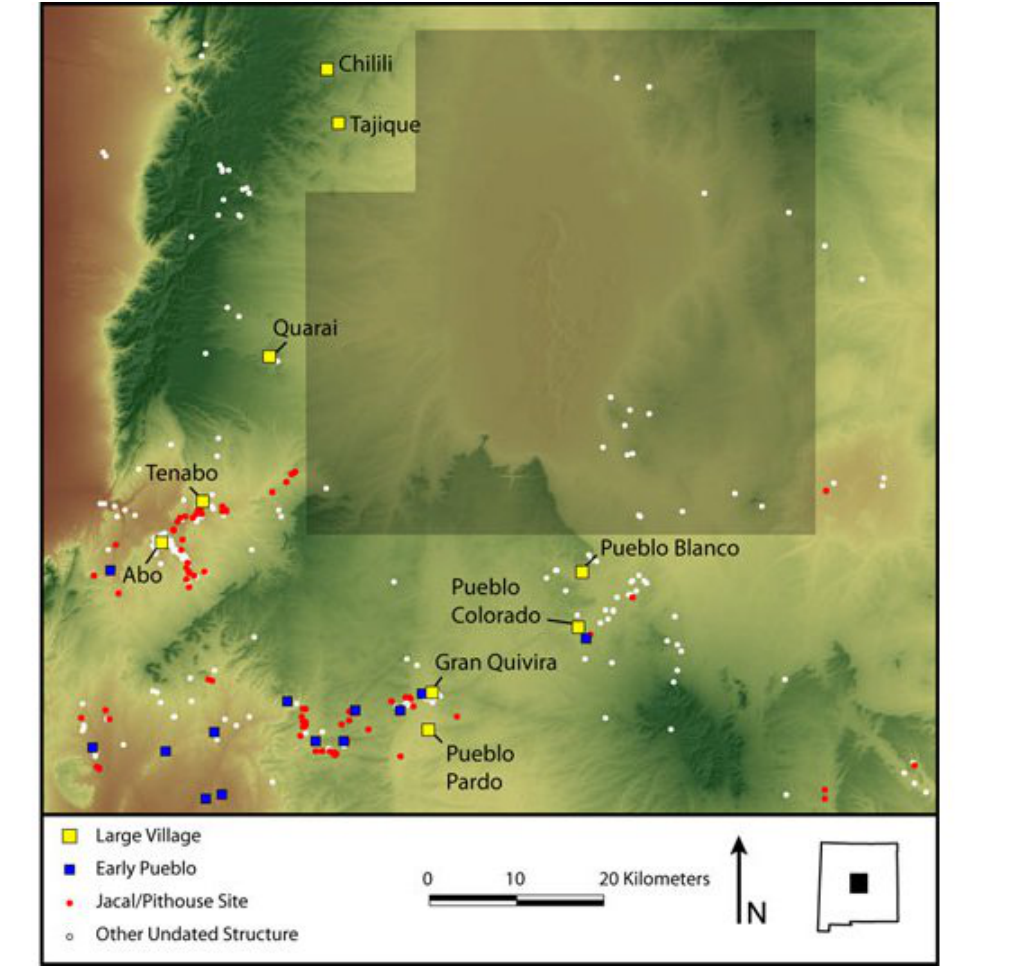
Fig. 5 . Jumanos sites in Salinas area. Note juxtaposition of pithouse, jacal, early pueblo and large village site locations. Source: Peeples 2009, unpublished manuscript